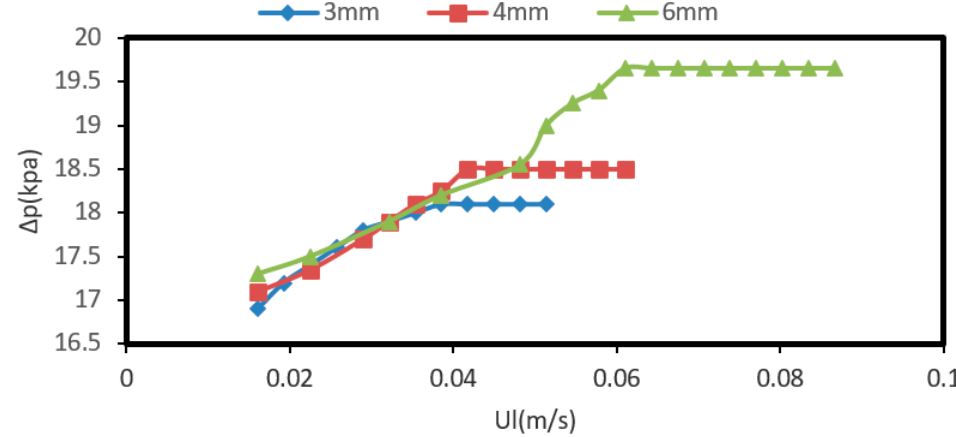
Figure 3. Variation of pressure drop with liquid velocity for different particle diameters.